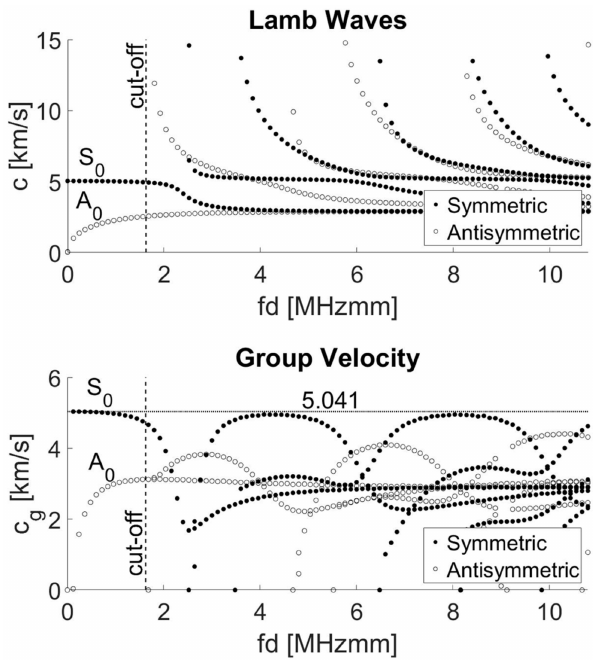
Figure 4. Rayleigh–Lamb curves: ( top ) wave speed and ( bottom ) group velocity dispersion